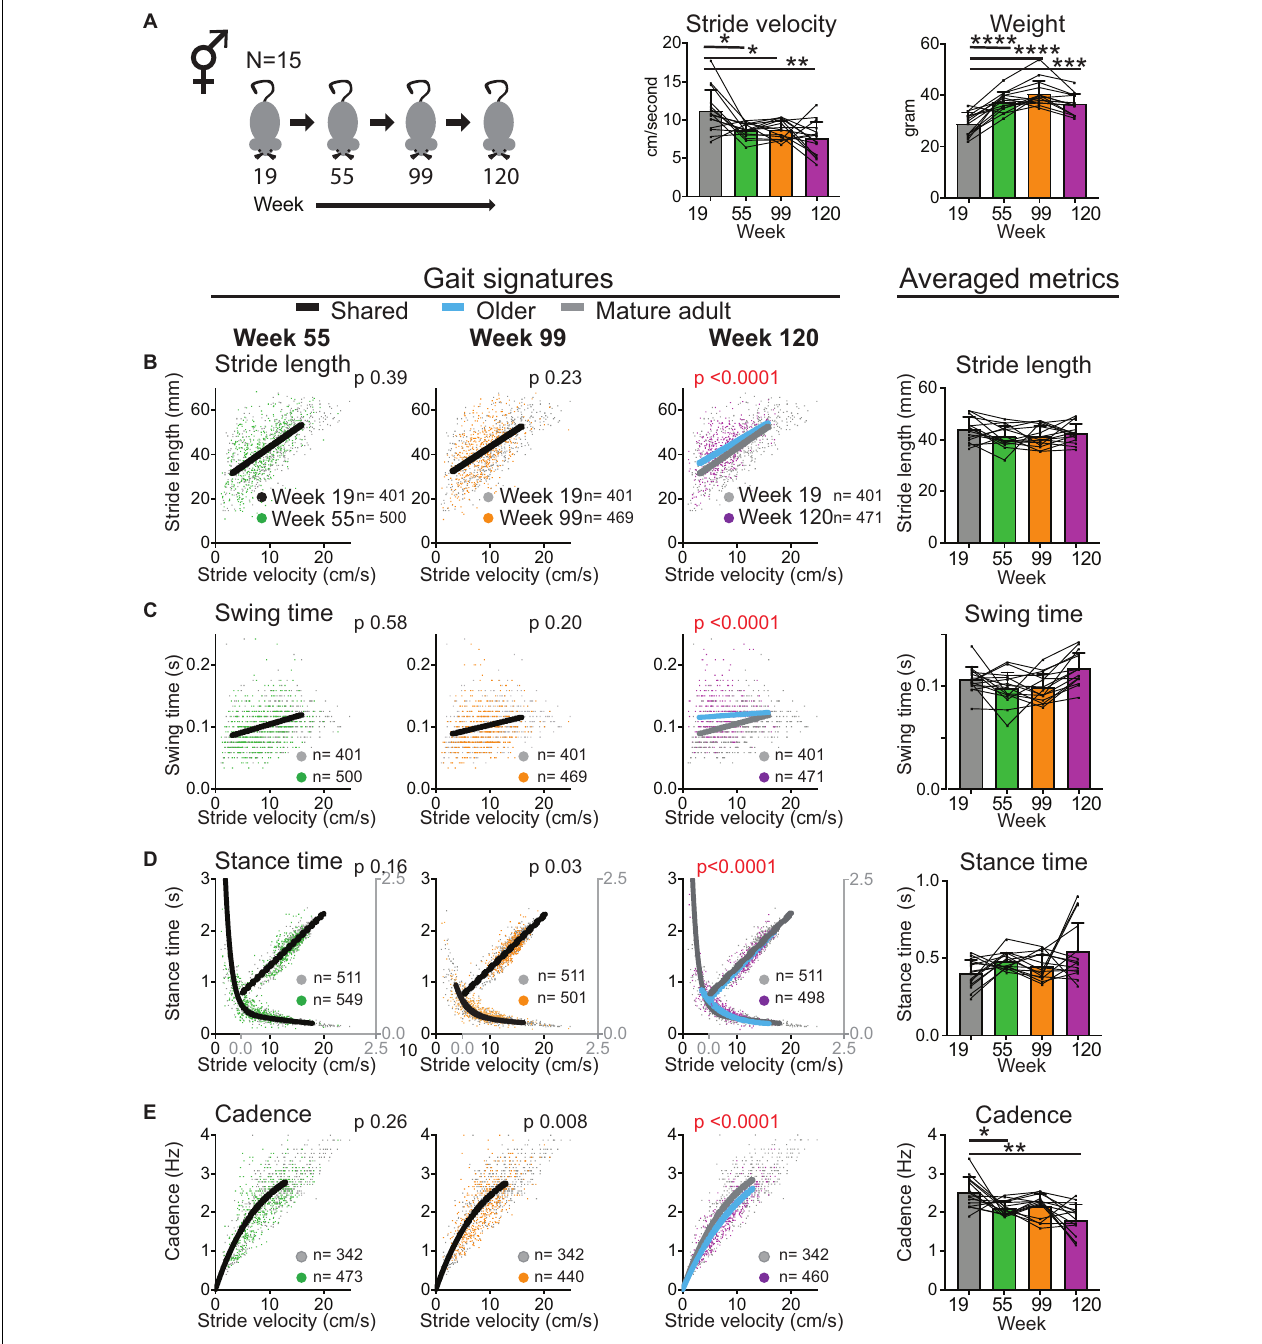
FIGURE 2 | Walking velocity declines early whereas gait signatures shift at geriatric age. (A) Bar graphs of average stride velocity from uninterrupted walking bouts on a walkway and weight at key time point during aging (mixed cohort N = 15). Error bars indicate standard deviation. RM-one-way ANOVA followed by Dunnett’s multiple comparison test with correction for multiple comparisons; family alpha 0.05. (B–E) Stride by stride gait metrics stride length (B) , swing time (C) , stance time (D), and cadence (E) plotted as a function of stride by stride velocity. Gray dots represent data from week 19 (mature adult) whereas green, orange, and purple represent data from weeks 55, 99, and 120, respectively. Single black curves or lines indicate that the dataset from week 19 and key time points fit the same curve, whereas separate lines indicate that datasets are significantly different (Sum of square F -test; alpha 0.001). Note the shift in curves or gait signatures (blue lines) in the geriatric age group (week 120). Bar graphs to the right show averaged metrics to illustrate variation between animals and time points. Error bars indicate standard deviation. RM-one-way ANOVA followed by Dunnett’s multiple comparison test with correction for multiple comparisons; family alpha 0.05. Curves were fitted for the velocity range that represents walking gait. N , number of mice; n , number of strides included in the analyses. Statistical analyses are summarized in Supplementary Table 1 . *, **, ***, and **** represent p values of < 0.05, < 0.01, < 0.001, and < 0.0001, respectively.